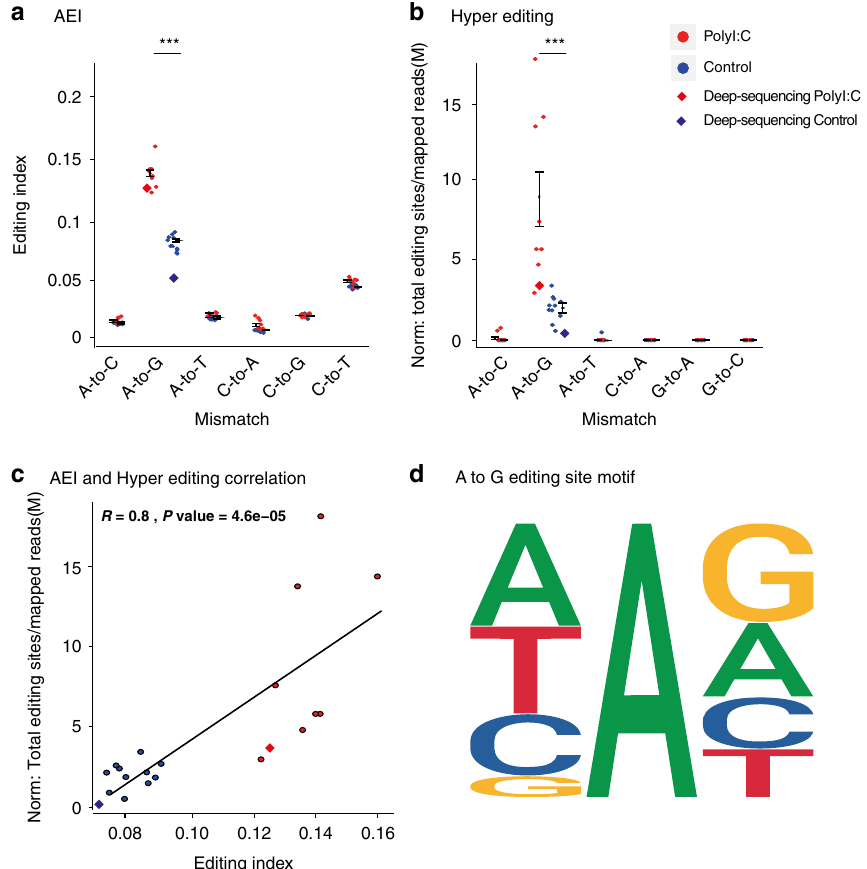
Fig. 3 Increased global levels of A-to-I RNA editing in PolyI:C-treated mice. Adenosine to inosine, which is read as guanosine (A2G Editing Index), RNA editing levels in PolyI:C mice sequenced on embryonic day 10 analyzed by a Alu Editing Index (AEI) on mouse B1 repetitive elements, and b hyperediting (HE) scheme applied to reads with an extensive editing rate that could not be aligned to the reference genome (two-sided Wilcoxon rank-sum test, p value = 2.6e − 05 ( W = 88) and 5.29e − 05 ( W = 87), respectively). Other mismatch types are considered noise. The levels of editing from the deep sequencing samples are indicated with a rhombus. c AEI and HE normalized editing levels are strongly correlated (Spearman, R = 0.8, p value = 4.6e − 6). d The familiar ADAR motif signature for the A-to-G sites could be identi fi ed. Source data are provided as a Source Data fi le. All values are means ±